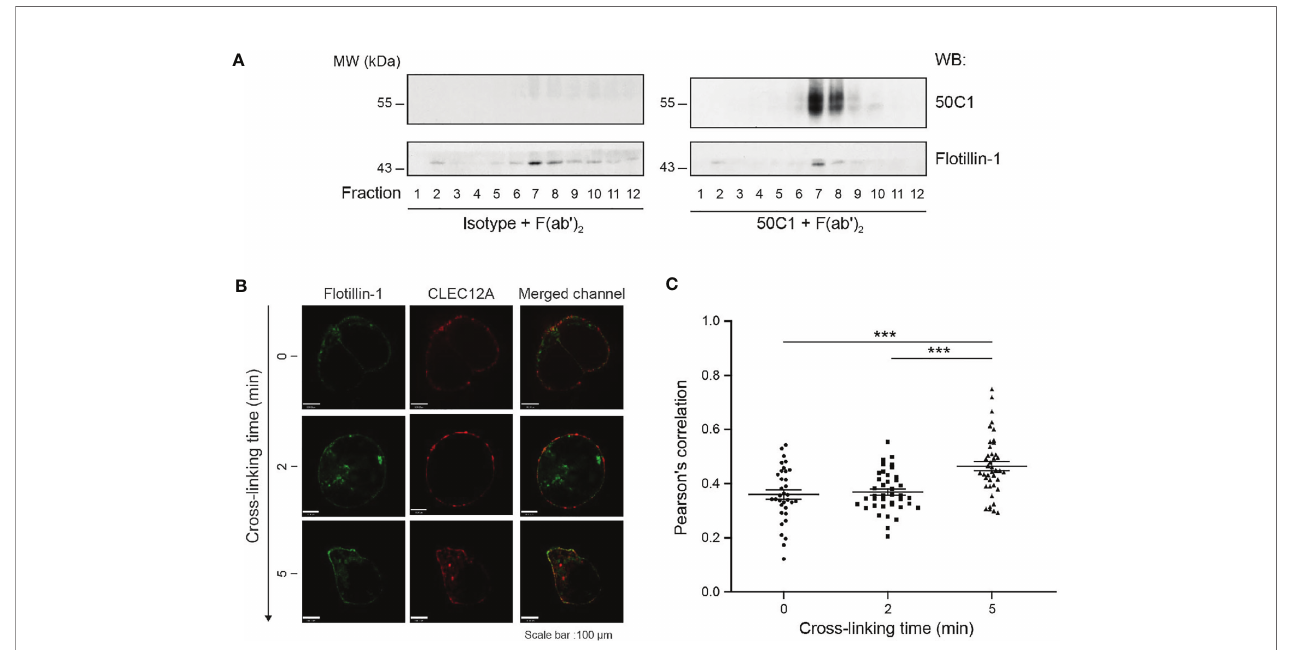
FIGURE 1 | CLEC12A translocates to detergent-resistant membrane domains after antibody-induced cross-linking. (A) Detergent-resistant membrane domains were isolated from plasma membrane preparations from human neutrophils incubated with an isotype antibody or 50C1 prior to cross-linking. Fractions were migrated on a non-reducing acrylamide gel and immunoblotted with 50C1 or fl otillin-1. Data are representative of 3 independent experiments. (B) Co-localization of CLEC12A and fl otillin-1 was determined in HeLa cells transiently expressing CLEC12A-HA-wt after cross-linking with an anti-HA antibody or incubation with the anti-HA antibody alone. Data are representative of 3 independent experiments. (C) The extent of co-localization was determined by Pearson R values (mean ± SEM) for the different cross-linking times. Statistical analysis: one way ANOVA and Dunn ’ s test were performed to compare cross-linked condition to control cells. ***P <